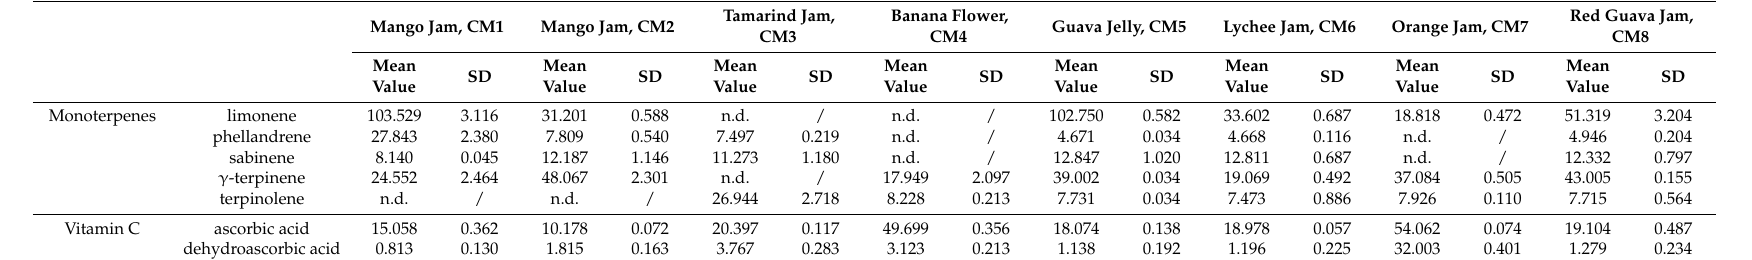
Table 3. Phytochemical fingerprint of monoterpenes and vitamin C in analysed jams and